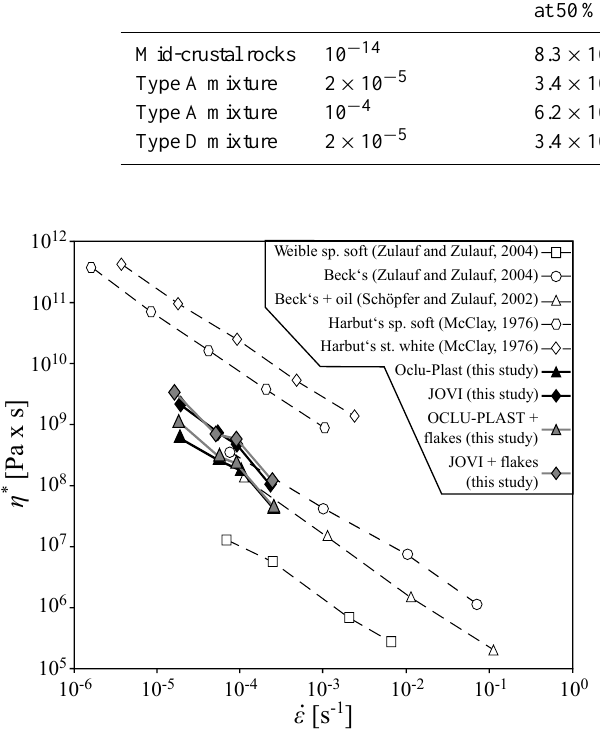
Figure 4. Log strain rate ( ˙ ε) vs. log effective dynamic viscosity ( η ∗ ) comparing the mixtures used in this study with other kinds of commercially available plasticine used by other authors. Effective dynamic viscosity values were taken at 10% shortening. Modified from Gomez-Rivas and Griera